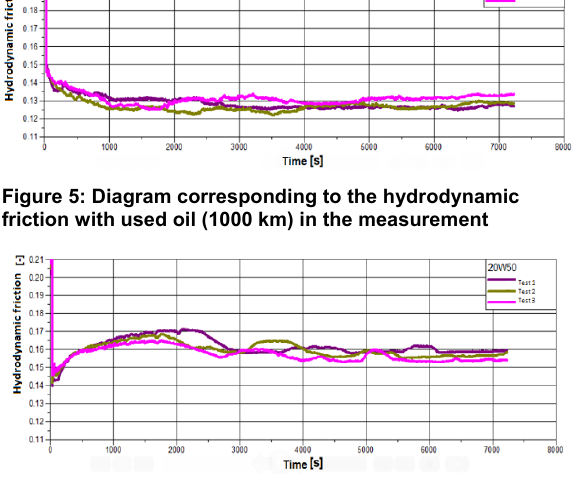
Figure 6: Diagram corresponding to the hydrodynamic friction with brand new oil (0 km) in the measurement If λ is greater than 3 in the Stribeck curve, we can